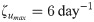
Simulated population dynamics of epithelial cells, immune effectors and bacteria in chlamydia infections.In A, the immune cell proliferation is rapid, which leads to an acute infection. In B and C, immune cells do not proliferate fast enough to clear the bacteria and the acute phase is followed by oscillations and the establishment of a chronic phase (plateau of EB density). The infection is lytic reducing the thickness of the epithelium (A, B and C) but only chronic infections manage to infect the lower layers (B and C). Parameter values are default (Table 3 and literature values in Table 1) except in A where βb = 8.0 × 10−7 cell−1⋅ EB−1⋅ day−1, βp = 4.0 × 10−6 cell−1⋅ EB−1⋅ day−1, βu = 2.0 × 10−5 cell−1⋅ EB−1⋅ day−1, and φ = 0.0015 day−1. In C, all four epithelial protective measures happen together, i.e. ζu, ρb, μ, and ν all rise logistically to a threshold above default after infection to mimic the protective epithelial response (see section A.3 S1 Text, eqn 7a with θ = 1). Thresholds used in C: ζumax=6day−1, ρbmax=0.3day−1, μmax = 0.9 cell−1⋅ day−1, and νmax = 0.8 day−1.